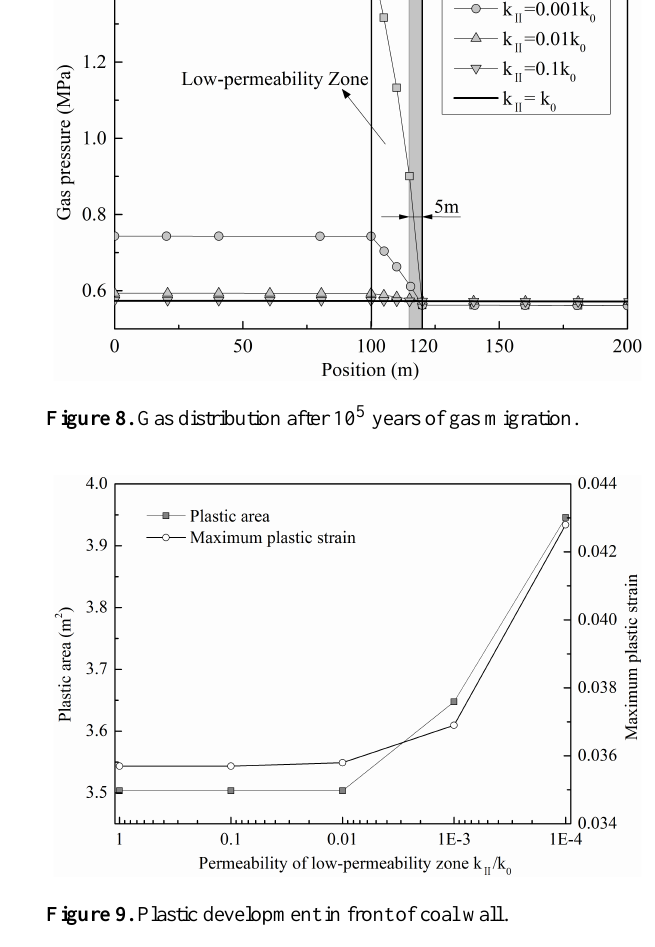
Figure 9. Plastic development in front of coal wall. 3